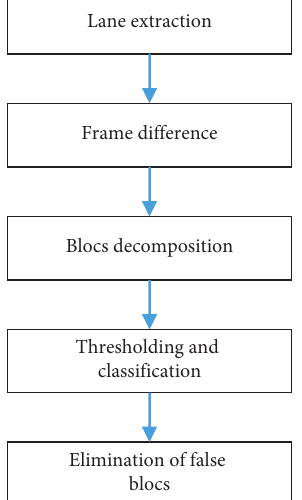
Figure 3: General process of the region of interest localization based on the method a contrario